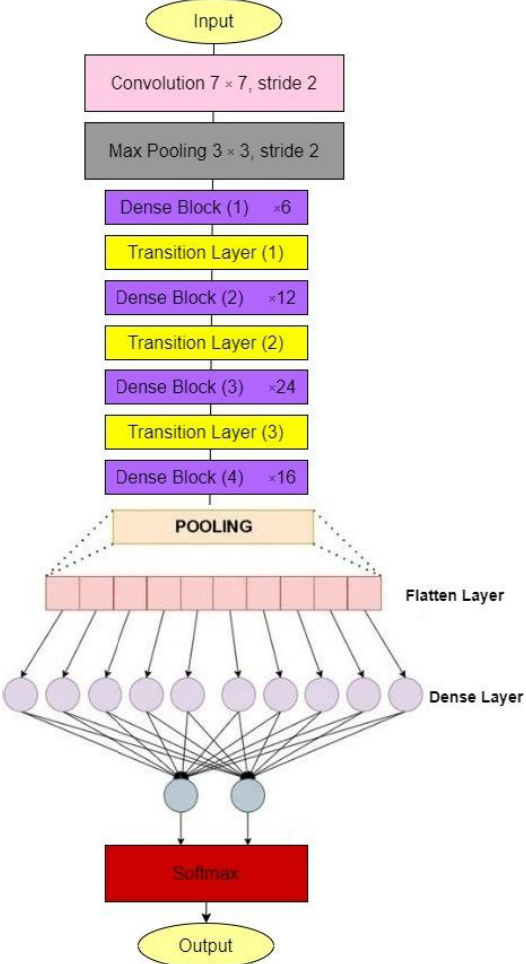
Figure 3. DenseNet121 architecture.